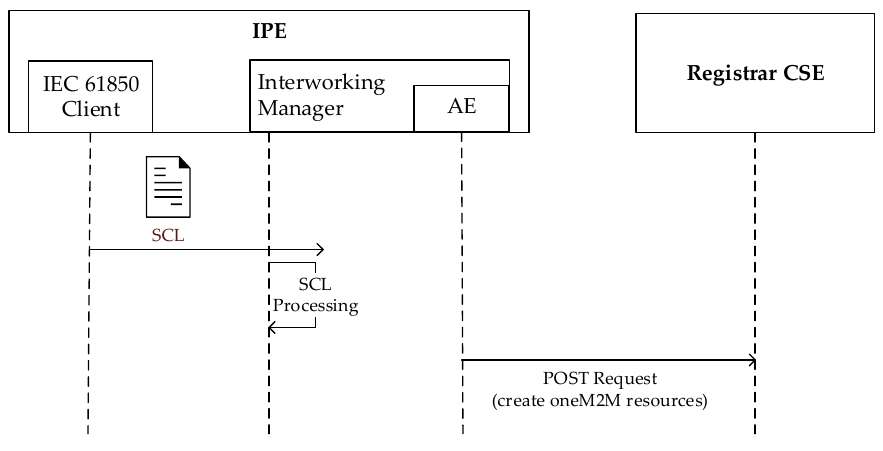
Figure 15. Operations performed by IPE at start-up.